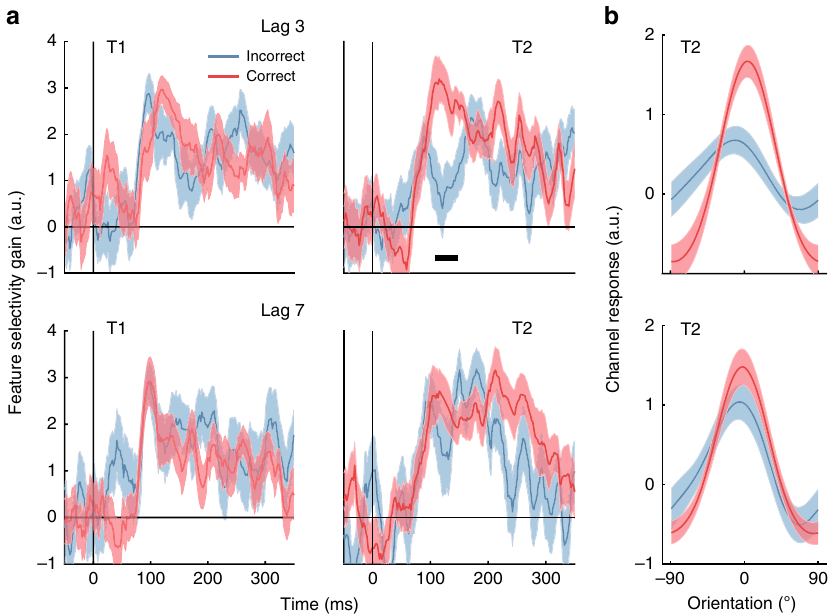
Fig. 6 Neural representations of feature-selective information during the AB for the fi rst (T1) and second target (T2) based on reporting accuracy for T2 for Experiment 2. a Time course of measured feature selectivity for T1 and T2, given by the gain of the fi tted Gaussian parameter. Trials were scored as correct if the participant ’ s response was within 30° of the presented orientation. Only trials in which participants responded accurately to T1 were included in the analysis. The thick black horizontal line in the upper right panel indicates a period of signi fi cant difference between Incorrect (blue lines) and Correct (red lines) trials (two-tailed sign- fl ipping cluster-permutation, alpha p < 0.05, cluster alpha p < 0.05, N permutations = 20,000). Note that the difference in magnitude for the encoding results shown in Fig. 5 is due to the increased number of training trials used in this analysis (12,000 vs 600). b Forward encoding results were averaged across the signi fi cant timepoints for T2 Lag 3 shown in ( a ) (upper right panel) to reconstruct the full representation of orientation. Reliable changes in the gain of orientation representations for T2 were present at Lag 3 (upper panel) but not at Lag 7 (lower panel). There was no difference in the width for either Lag. Shading indicates ∓ 1 standard error of the